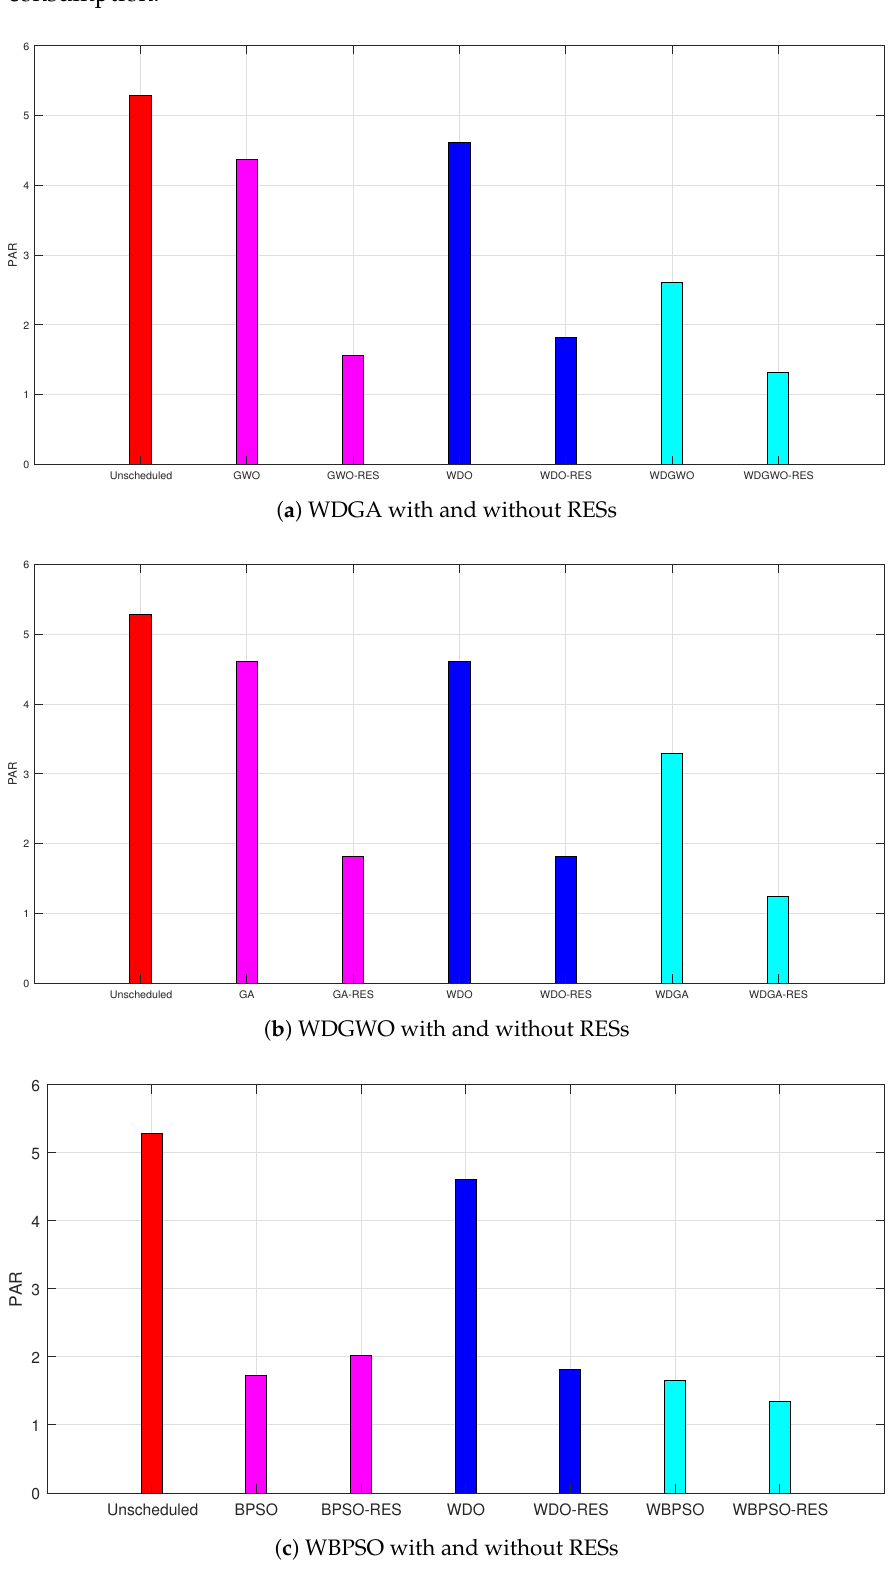
Figure 11. PAR with and without